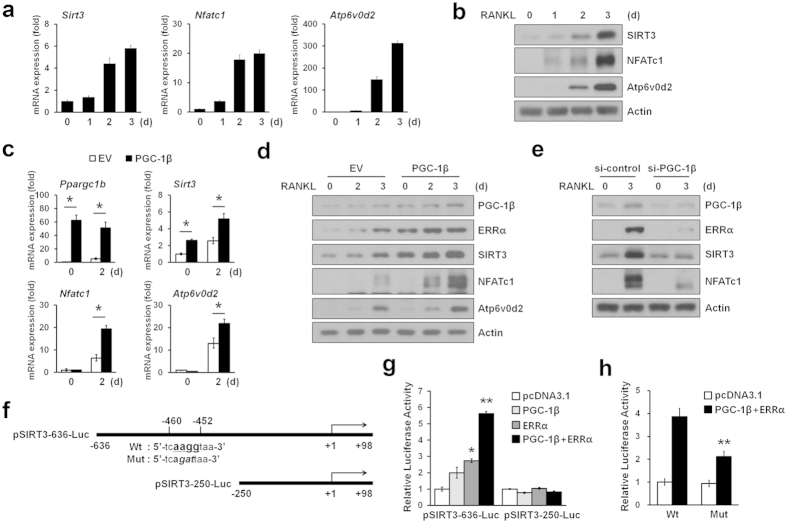
PGC-1β regulated the expression of SIRT3 during osteoclastogenesis.(a) BMMs were induced to differentiate into osteoclasts with RANKL for indicated days. Relative mRNA levels of Sirt3, Nfatc1, and NFATc1-induced genes Atp6v0d2 were analyzed by qRT-PCR. (b) Immunoblot analysis of SIRT3, NFATc1, and Atp6v0d2 expression during osteoclast differentiation. Actin served as a loading control. (c) BMMs infected with retroviruses expressing PGC-1β or empty vector (EV) were stimulated with RANKL for 2 days. Total RNA was subjected to qRT-PCR analysis to assess Ppargc1b, Sirt3, Nfatc1, and Atp6v0d2 mRNA levels. *P < 0.01 between the indicated groups. (d) As in (c), except that cell lysates were subjected to immunoblot analysis with the indicated antibodies. Immunoblot analysis showed that SIRT3 protein level was induced by PGC-1β. (e) BMMs were transiently transfected with either irrelevant siRNA (si-control) or PGC-1β siRNA and were stimulated with RANKL. Cell lysates were subjected to immunoblot analysis with the indicated antibodies. (f) Schematic representation of the mouse SIRT3 promoter-luciferase reporter constructs. pSIRT3-636-Luc containing a consensus ERRE site (Wt) and mutated ERRE site (Mut), respectively. (g) Expression plasmids for PGC-1β, ERRα or vector control were transfected into the HEK293T cells, along with the indicated pSIRT3-Luc constructs. The relative luciferase activity was corrected for Renilla luciferase activity and normalized to the vector control activity. (h) HEK293T cells were transiently co-transfected with a luciferase reporter plasmid containing a wild-type SIRT3 promoter construct pSIRT3-636-Luc or a mutant construct of the ERRE binding site together with the PGC-1β and ERRα expression plasmids. After 24 h incubation, cells were then assayed for relative luciferase activity. All values represent at least three independent transfections, each conducted in triplicate. Data represent means ± SD *P < 0.01, **P < 0.005.